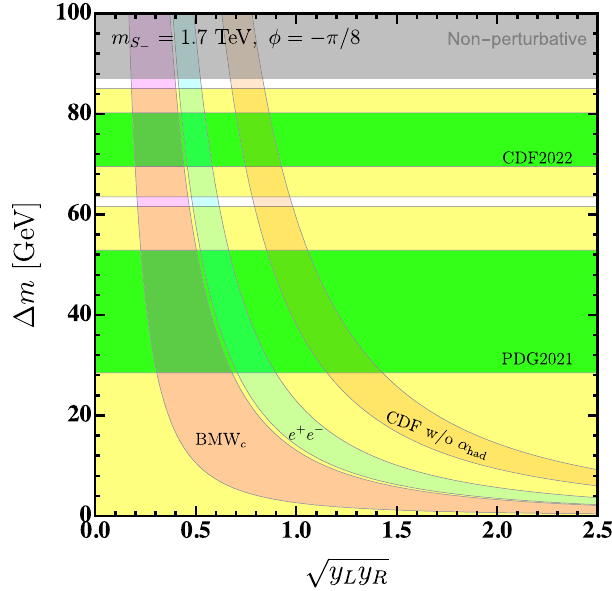
p ffiffiffiffiffiffiffiffiffiffi planeofourLQ y L y R =1 : 7TeV.Thegreyregion ffiffiffiffiffiffi p (cid:1) 4 π